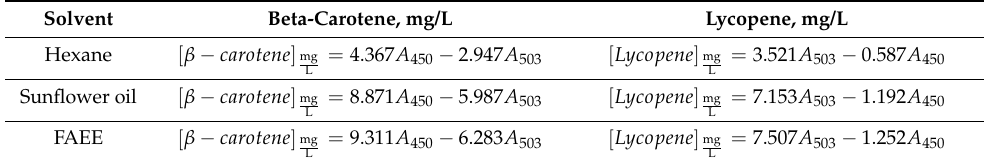
Table 1. Equations for the UV-vis spectroscopy determination of beta-carotene and